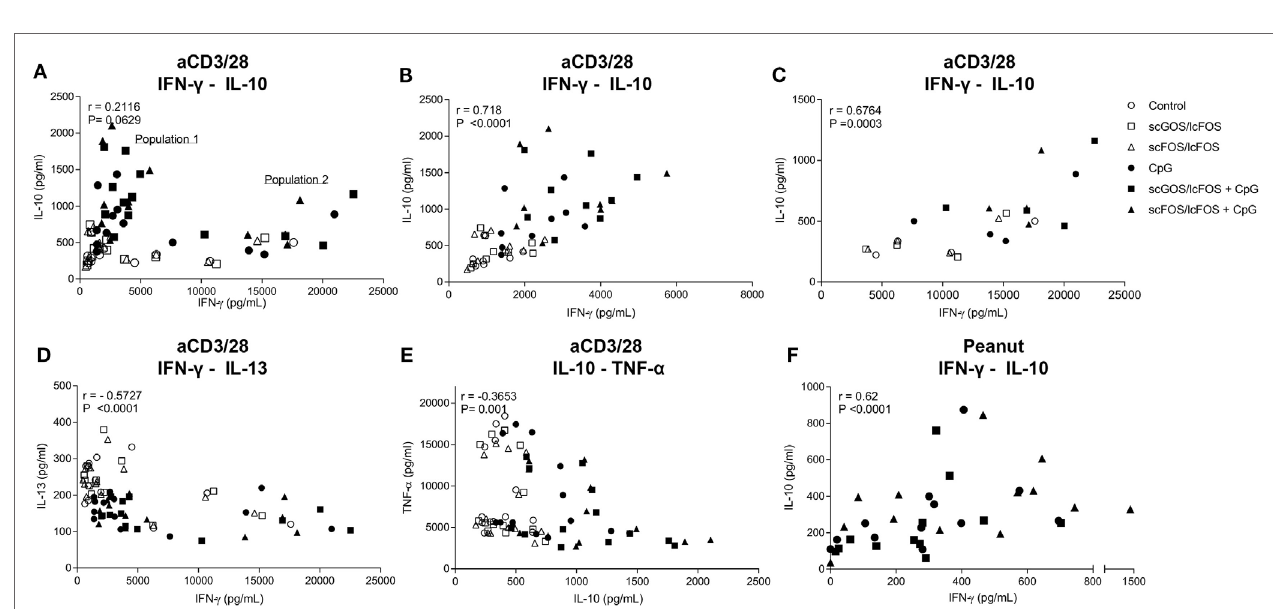
FigUre 4 | Correlation of cytokine production. IFN- γ and IL-10 concentrations were positively correlated in both the aspecific and peanut-specific co-culture models (a–c,F) . In the aspecific model, a clear distinction could be made into two populations (B,c) . Population 2 was comprised of four patients for all data points. A negative correlation existed between IFN- γ and IL-13 concentration (D) and TNF- α and IL-10 concentration (e) . Data represent n = 12–13 peanut-allergic patients. Correlation was tested with Spearman’s rank correlation coefficient.